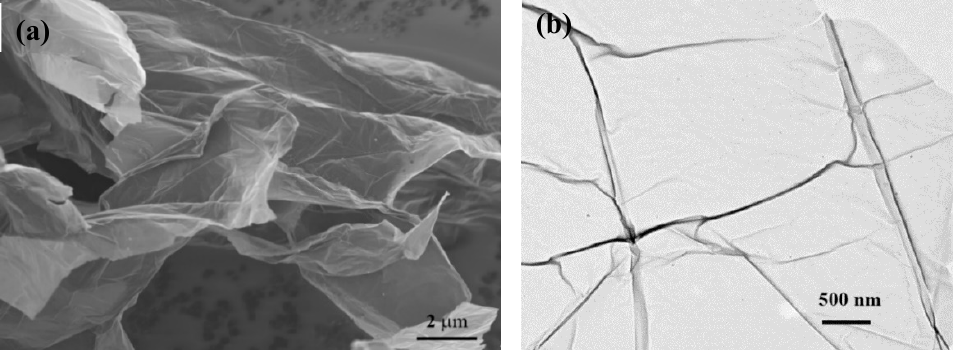
Figure 4. Electron micrographs of graphene oxide: ( a ) SEM micrograph of graphene oxide nanosheet. ( b ) TEM micrograph of graphene oxide nanosheet.